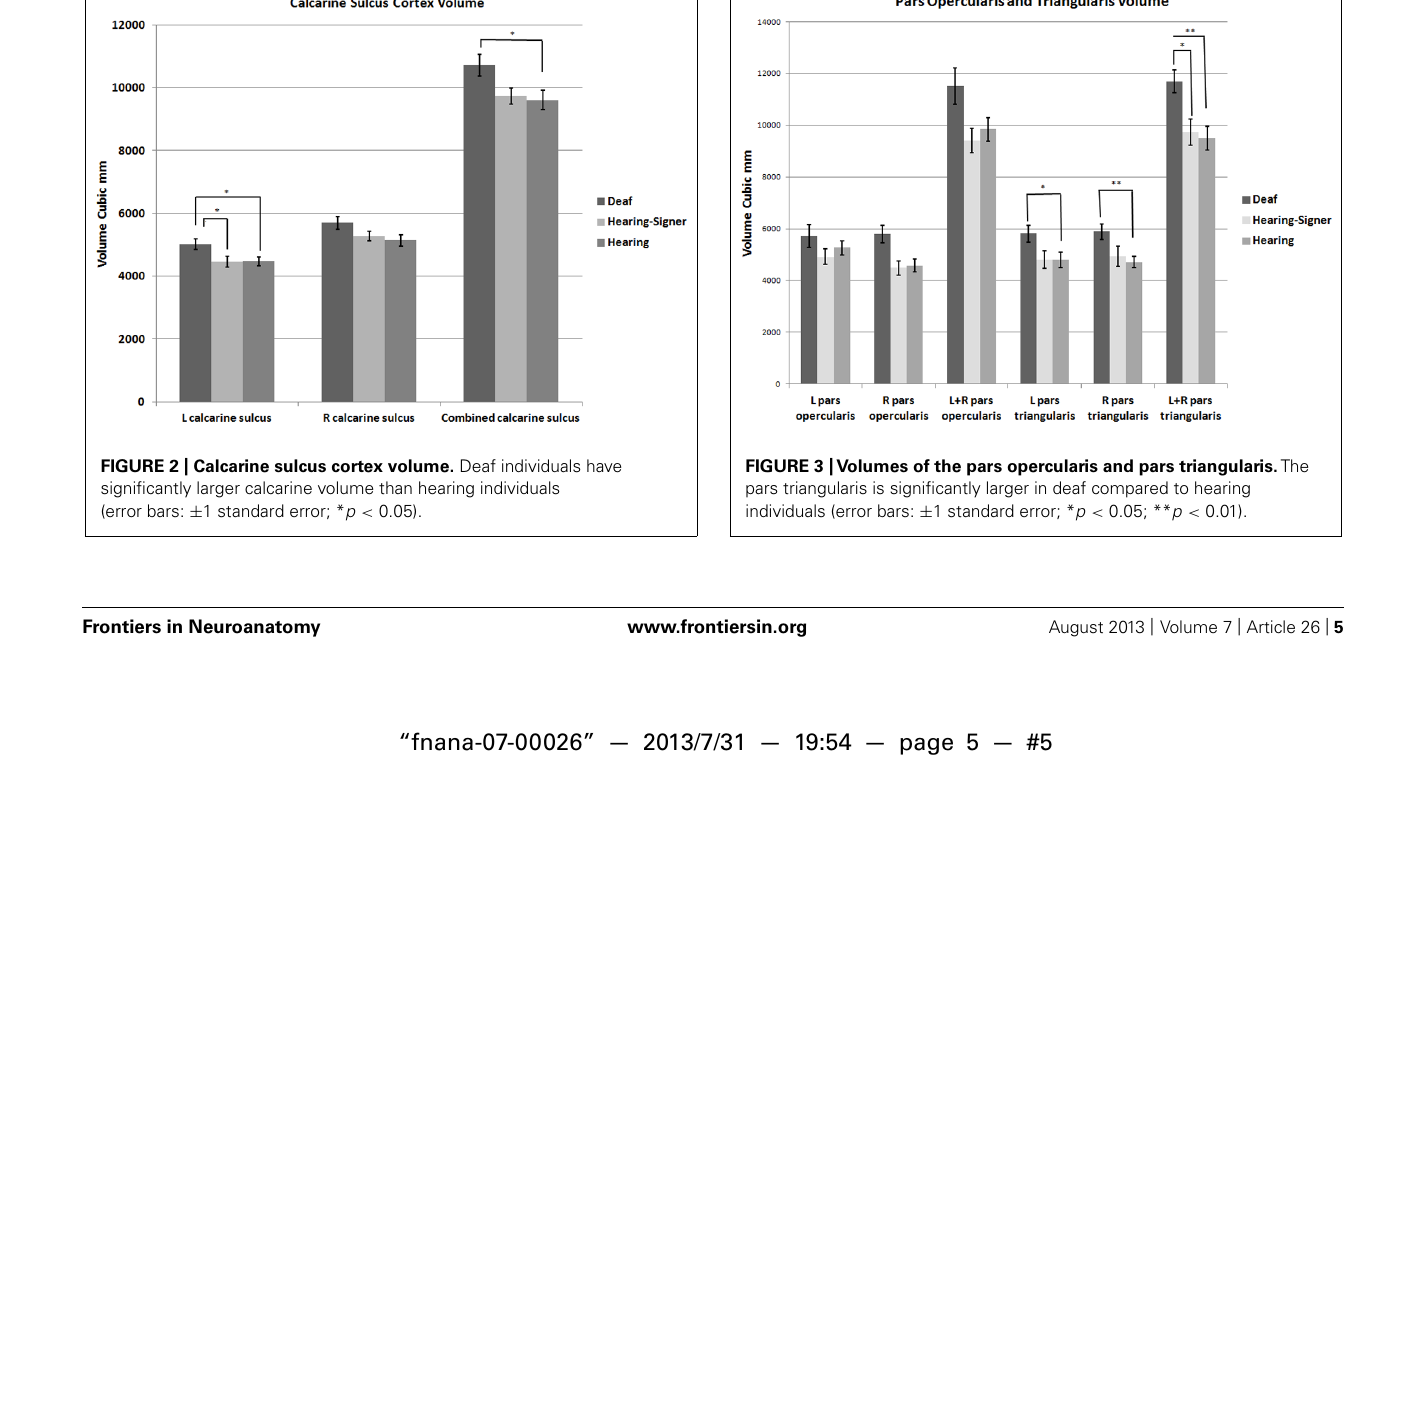
Hearing signers